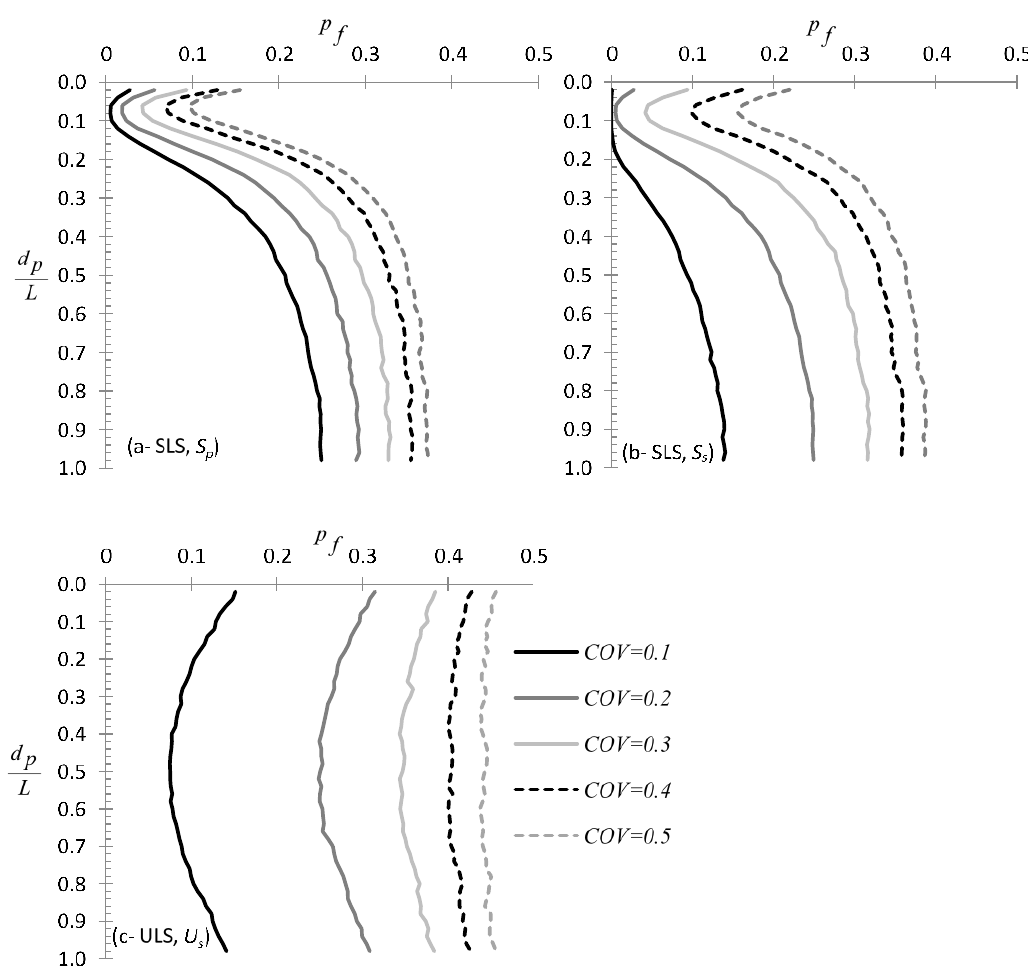
S ( SLS S ( SLS state), ( b ) s p